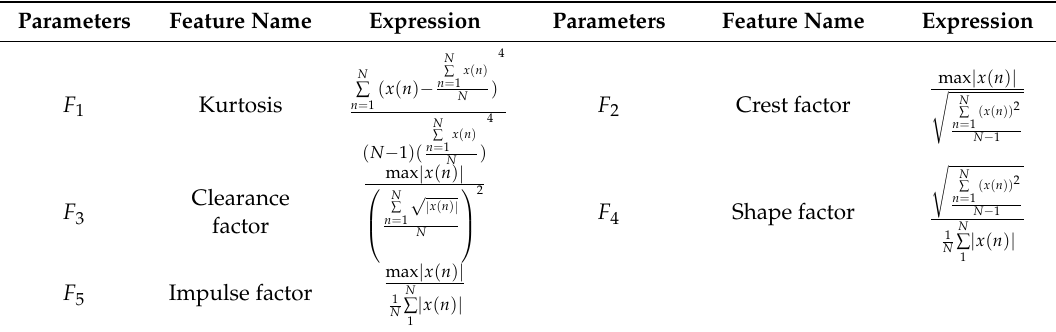
Table 4. Statistics feature parameters.